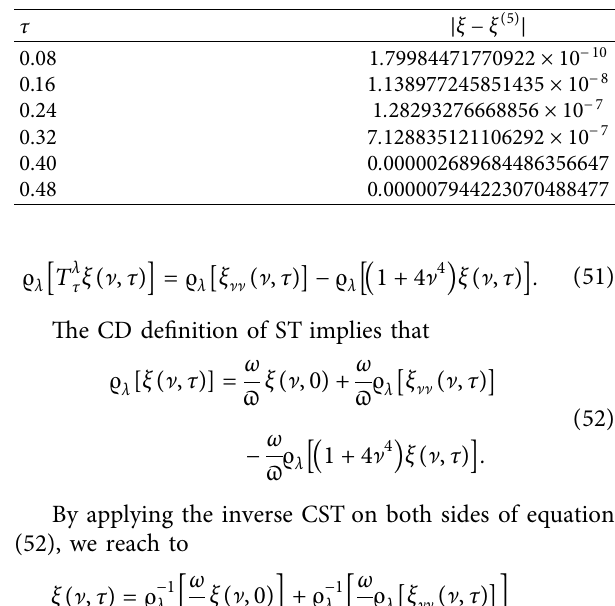
Table 1: The absolute errors for Example 1 at λ